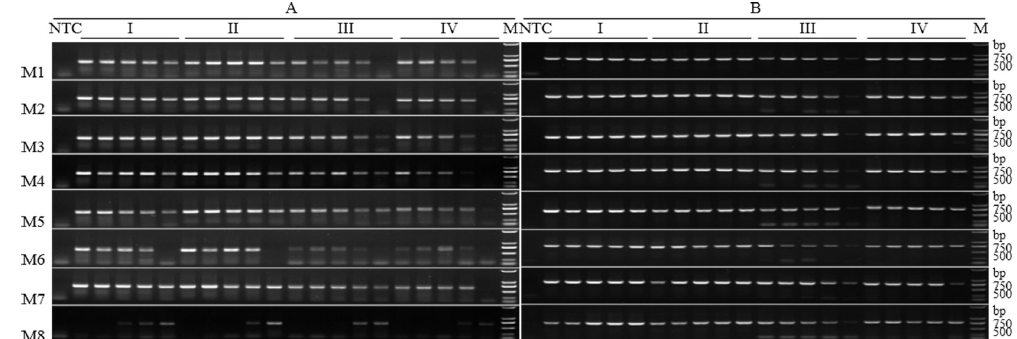
Fig 2. PCR amplification pattern of COI (A) and 28S (B) genes for testing the DNA quality extracted specimens preserved for four durations by using eight commonly used DNA extraction methods. Preservation methods I-IV are fresh, short period, intermediate period, and long period. Five lanes are shown for each method, from left to right: DNA samples extracted from an adult mealybug, 3rd, 2nd and 1st instar nymphs, as well as individual eggs. M: Trans2K DNA Marker; NTC: negative control (ultrapure